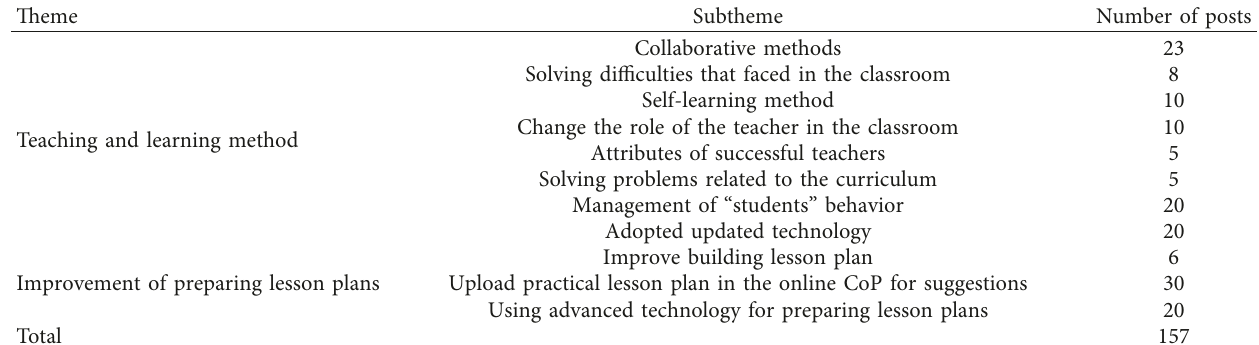
Table 3: Teachers’ contributions in the online CoP